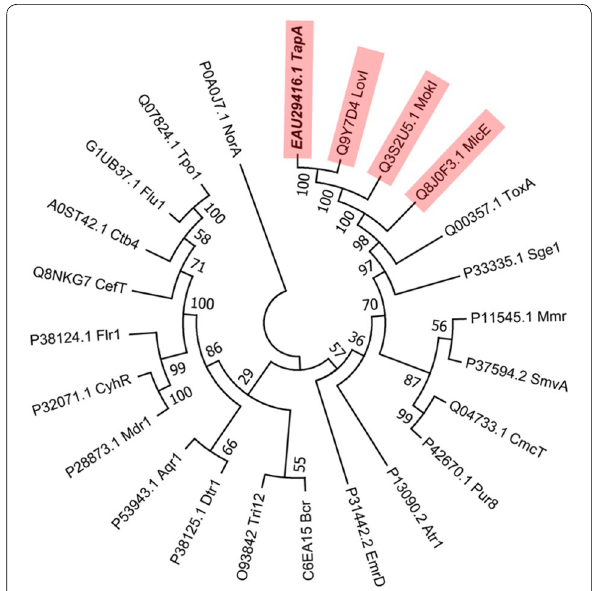
Fig. 1 Phylogenetic analysis of MlcE homologs from various strains. The evolutionary tree was inferred by MEGA7 using the Neighbor-Joining method (Saitou and Nei 1987). Values indicated the number of times (in percentages) that each branch topology was found in 1000 replicates of a bootstrap analysis. The evolutionary distances were computed using the Poisson correction method (Zuckerkandl and Pauling 1965) and are in the units of the number of amino acid substitutions per site. Information of strains and proteins were listed in Additional file 1: Table